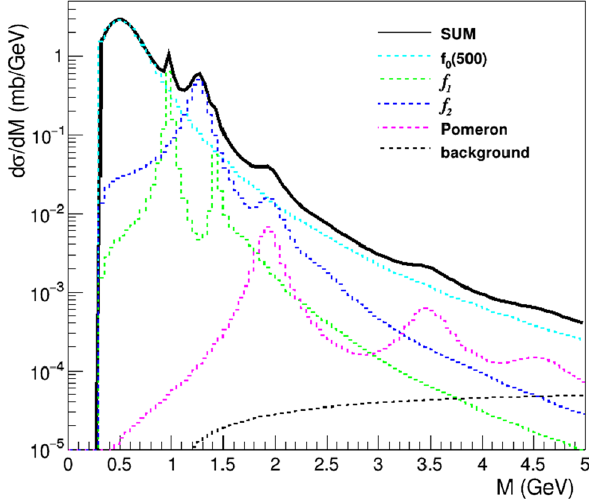
Fig. 9 Double differential meson cross section for contribution of f 1 trajectory